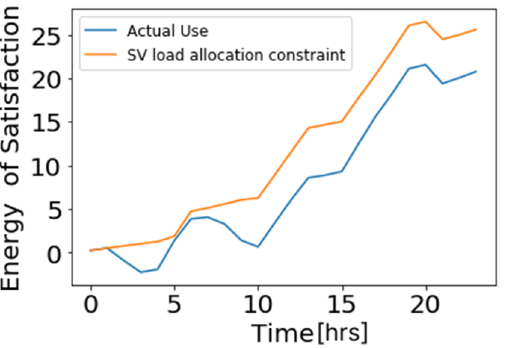
Figure 4. Energy satisfaction (ES) with the proposed SV load allocation using the same or less energy than real REDD [31] database vs. ES satisfaction using REDD [31] database.